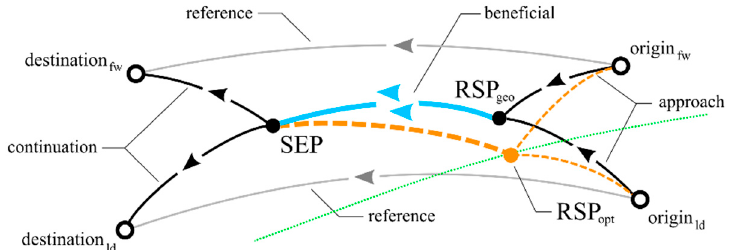
Figure 4. General construction of formation route geometry (FRG) with approach and continuation segments (black), reference tracks (gray) and beneficial segment (blue); RSP adaption due to timing constraints (orange) and qualitative representation of a rendezvous line (green).